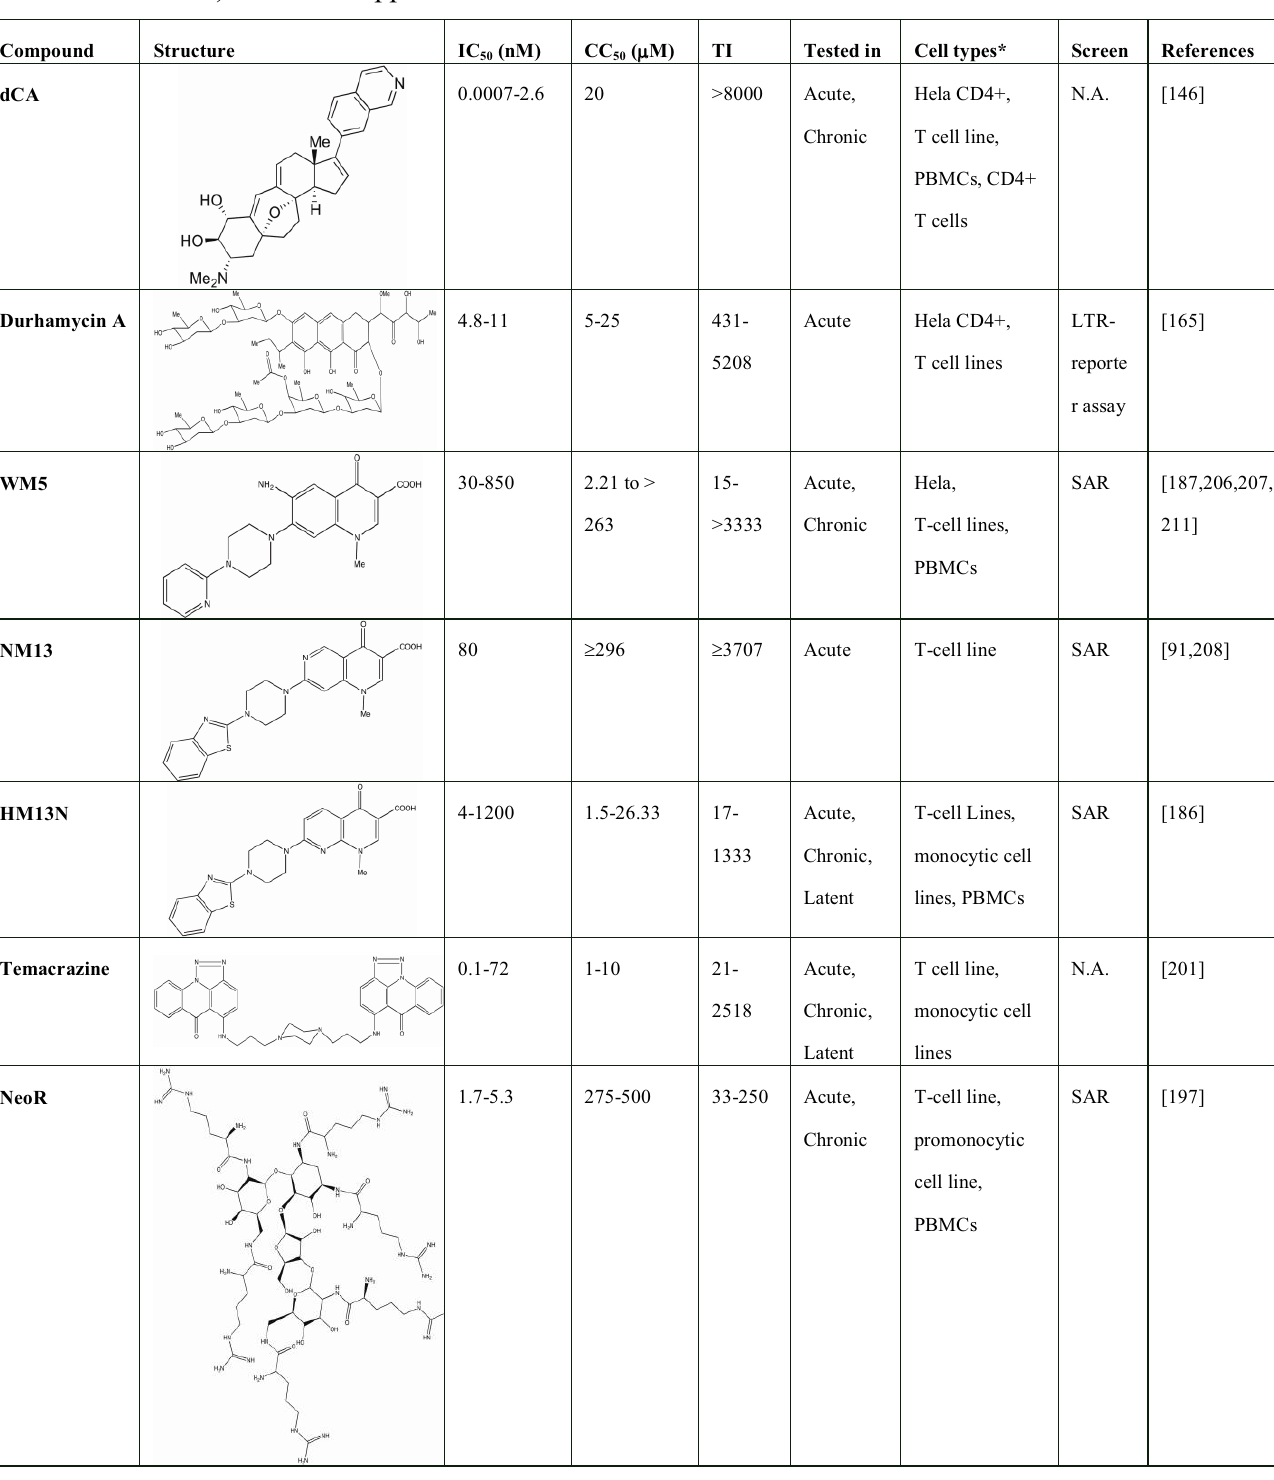
Table 1. Activity, cytotoxicity and therapeutic index of selected HIV-1 Tat-dependent transcription inhibitors. Acute, chronic and/or latent cell lines where HIV-1 has been significantly inhibited are listed. The type of screen, when applicable, and the compound structure are indicated. (* Note: The IC and CC have not been determined in every cell 50 50 lines listed). N.A.: not